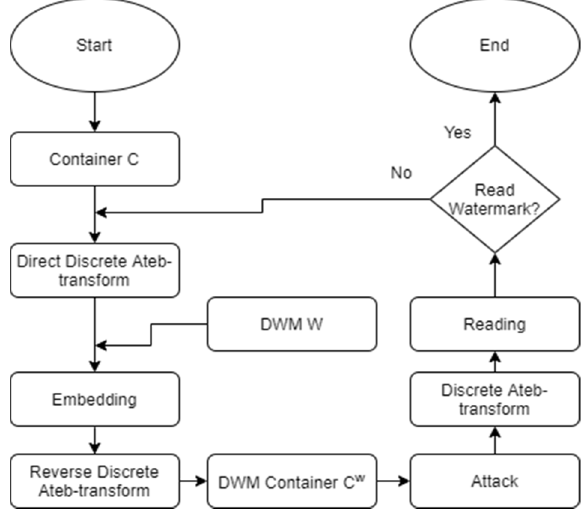
Figure 1. Flowchart for conducted experiments.